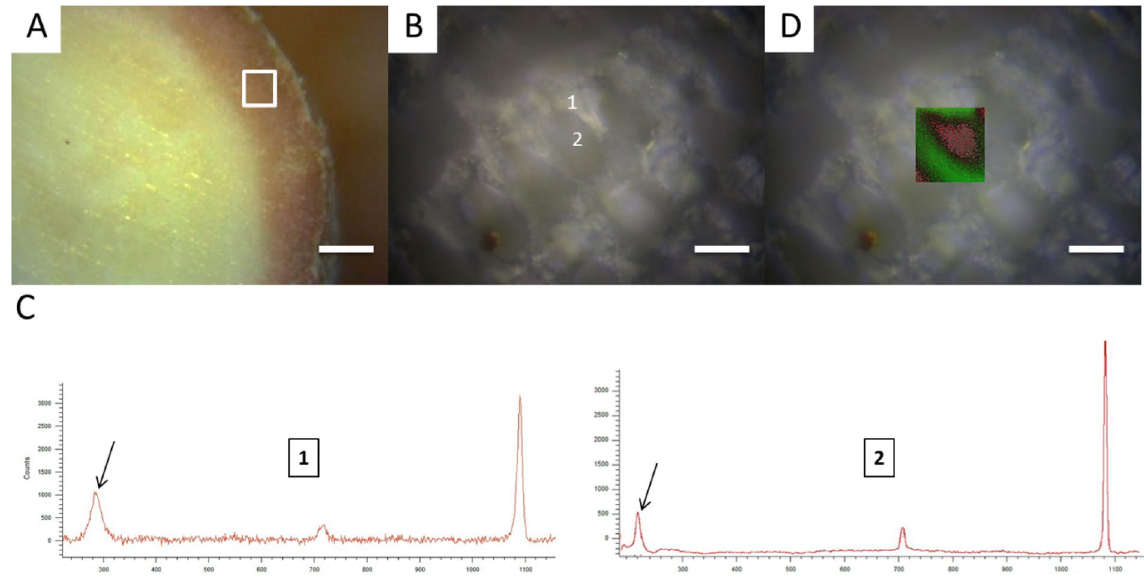
Figure 3. Low magnification view of coralline algae thallus with the selected area for Raman analysis marked (white square) ( A ; scale bar: 200 µm). Optical microscopy image of coralline algae cells with numbers 1 and 2 representing the punctual Raman analysis of the cell ( B ; scale bar: 20 µm) and their respective Raman spectra with a black arrow indicating the peaks that were used to differentiate high-Mg calcite ( C ; black arrow indicates the 281 cm −1 calcite peak) from aragonite (2; black arrow indicates the 208 cm −1 aragonite peak). Optical microscopy image overlaid by Raman mapping shows the prevalence of high-Mg calcite (green) in the internal cell wall and aragonite (red) as a “shell” in the inner part of the cell ( D